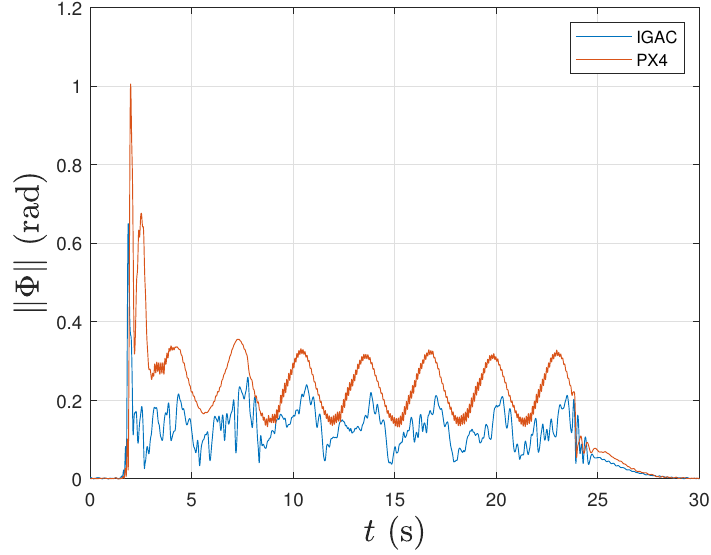
Figure 17. Principal angle error in SITL